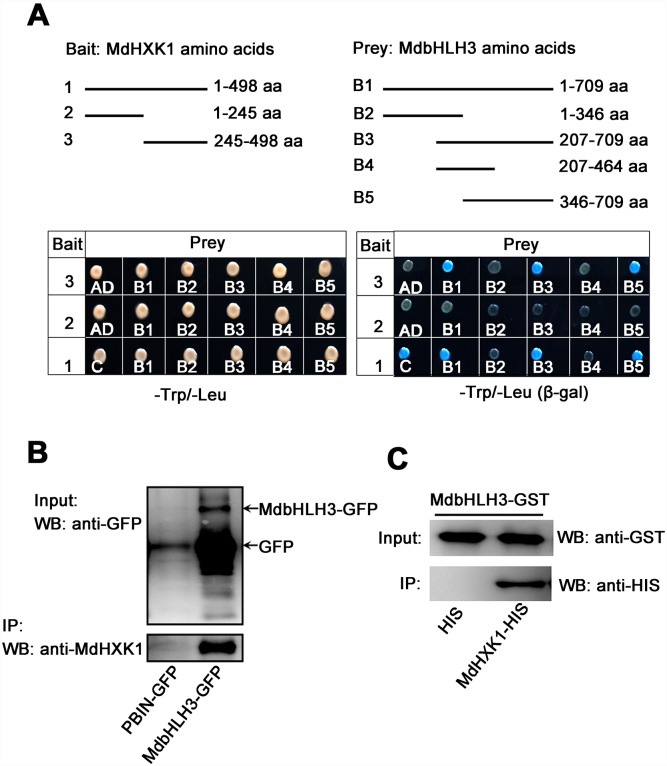
MdHXK1 physically interacts with MdbHLH3.(A) The C-terminus of MdHXK1 specifically interacts with the C-terminus of MdbHLH3 in a yeast two-hybrid assay. Top panels show the schematic representation of the different MdHXK1 and MdbHLH3 deletions in yeast vectors. Bottom panels show their interaction as indicated by yeast growth and β-gal staining in a serial of yeast two-hybrid assays. (B)
In vivo Co-IP assays of the interaction between MdHXK1 and MdbHLH3 in transgenic apple calli. (C)
In vitro GST pull-down assays of the interaction between MdHXK1 and MdbHLH3. Anti-His immunoblot (IB) shows the amount of MdHXK1-His bound by the indicated MdbHLH3-GST protein.